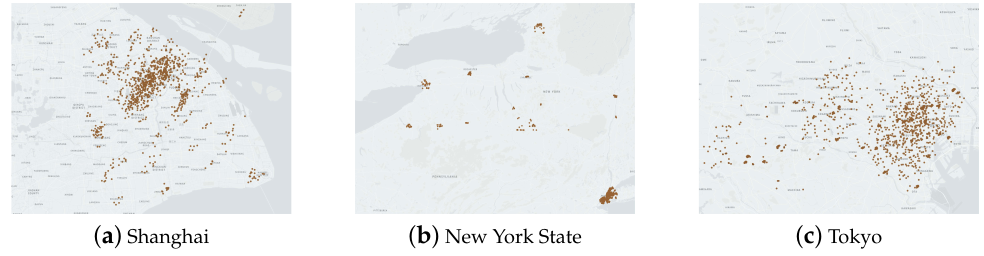
Figure 4. Landmark distribution in the three regions.